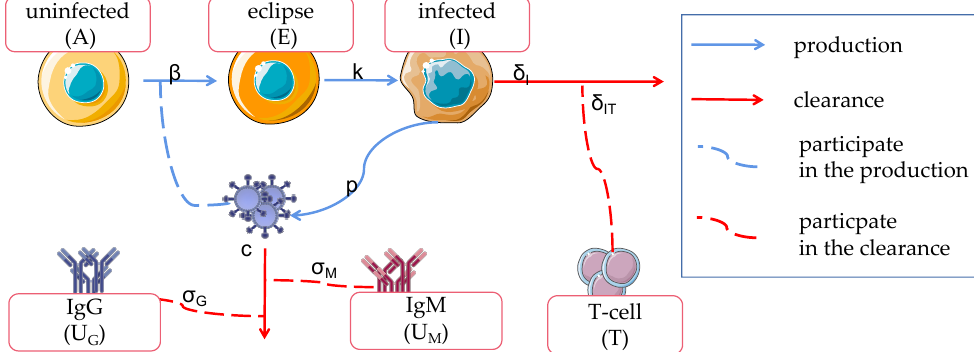
Figure 1. Viral infection and immune response diagram. ‘Production’ means conversion between cells or cell cleavage to produce viruses; ‘Clearance’ means virus inactivation or cell death; ‘Participate in the production’ refers to viral infection; ‘Participate in the clearance’ includes the role of antibodies against the virus and T cell-induced apoptosis in infected